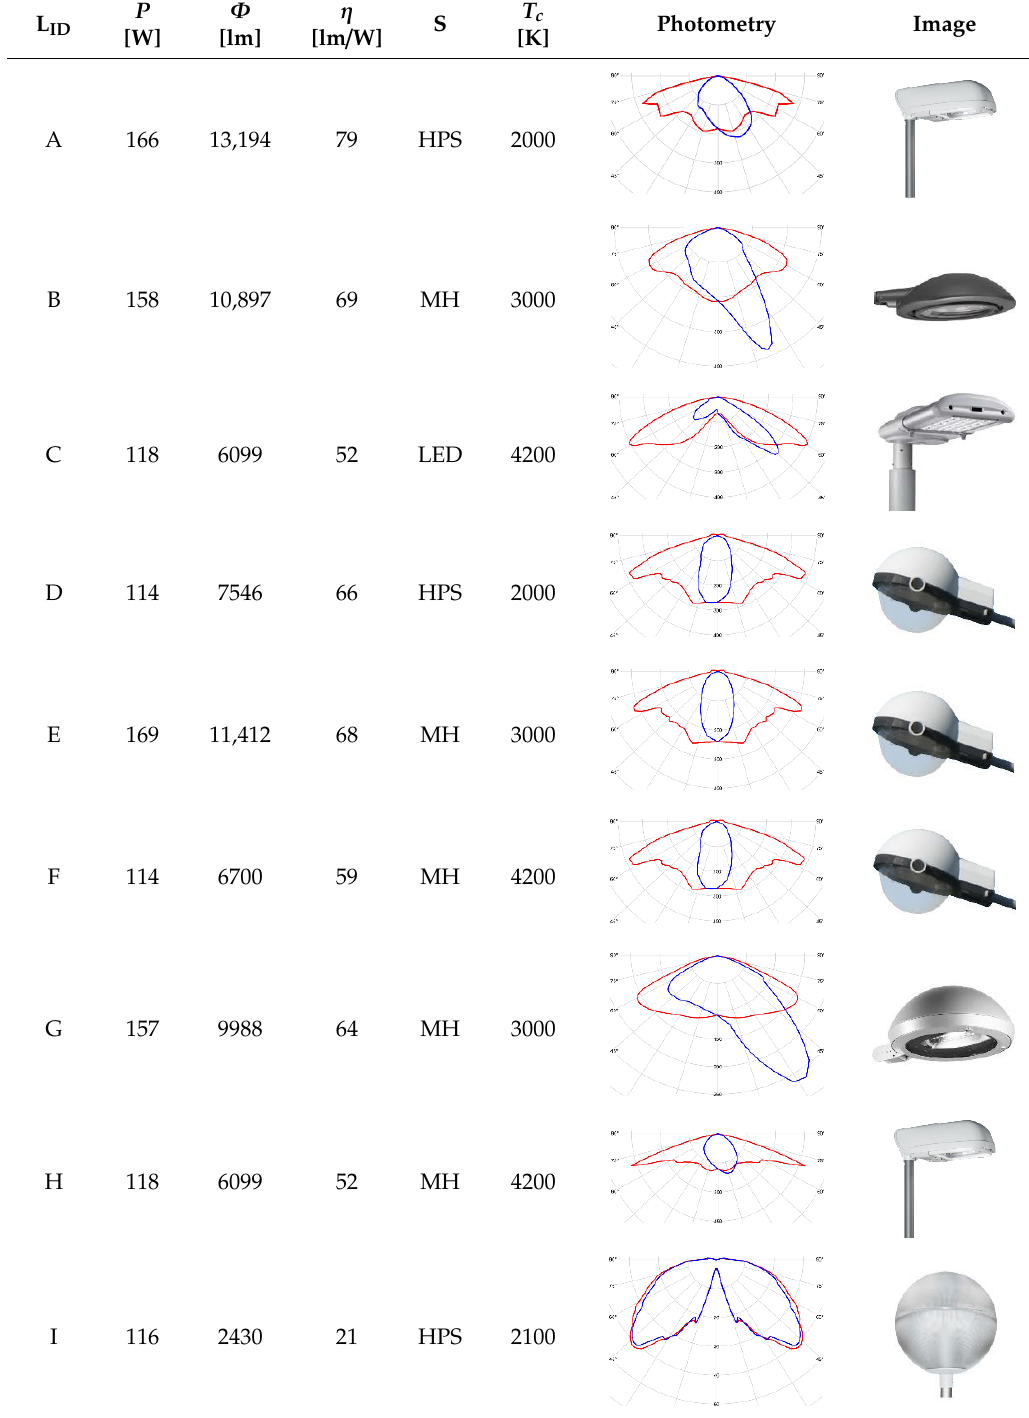
Table 6. Photometric data of the luminaires at the present status. The following symbols are used; L ID : luminaires identification letter; P : luminaire power; Φ : luminaire luminous flux; η : luminaire efficacy; S: source type; T c : correlated colour temperature; HPS: High Pressure Sodium; MH: Metal Halide; LED: light-emitting diode.